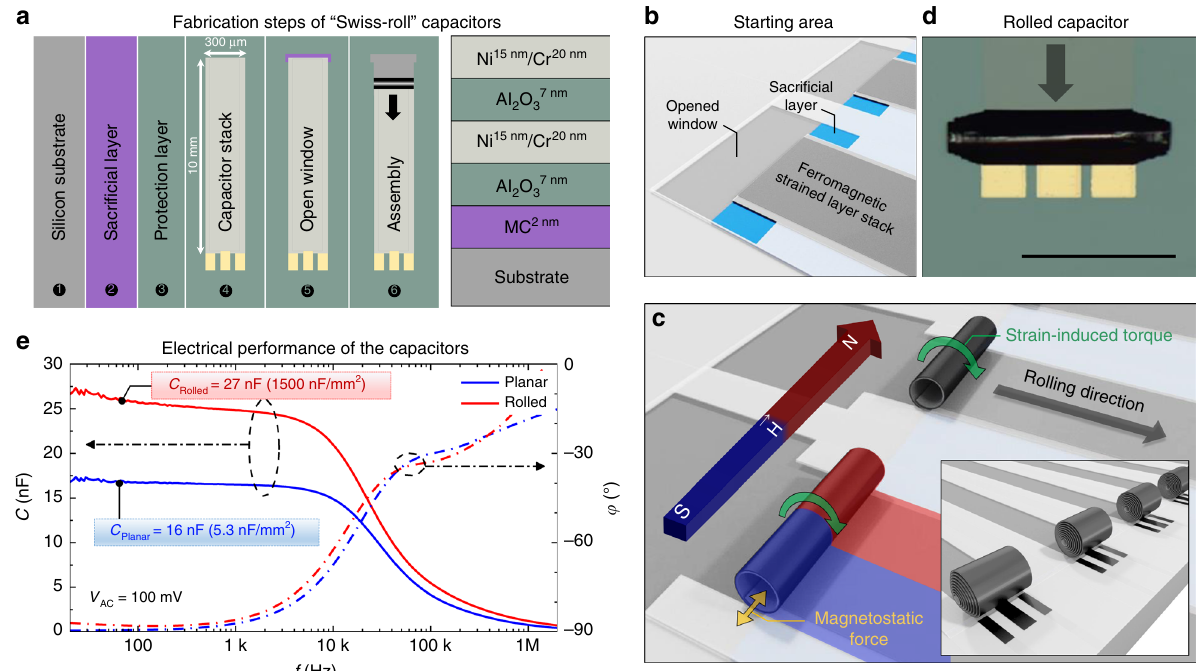
Fig. 4 Fabrication of electrostatic capacitors using axial static magnetic fi eld assembly. a Capacitor fabrication steps and cross-section of planar layer stack. b Rolling process is initiated by wet release of the ferromagnetic-strained layer stack from the sacri fi cial layer starting at the opened windows. c During the strain-induced self-assembly, the capacitors are stabilized by an axially (perpendicular to desired rolling direction) applied magnetic fi eld ~ H and the arising magnetostatic forces between the magnetized windings. The inset illustrates the fi nal assembly state. d Optical microscopic image of the assembled capacitor. Scale bar is 200 μ m. e Capacitance and phase angle as a function of frequency including areal capacitance density for planar and rolled